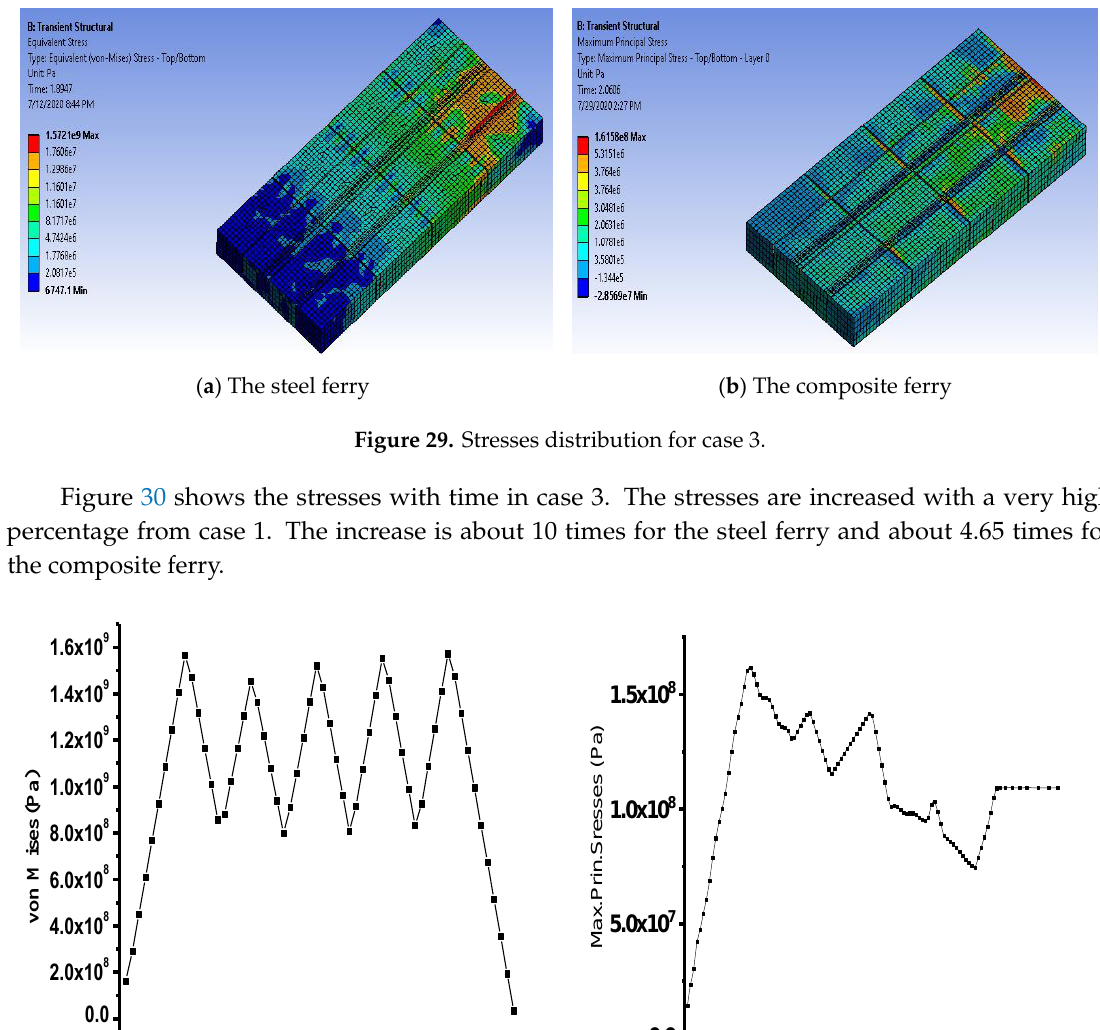
Figure 28. The total deformations with time for case 3.